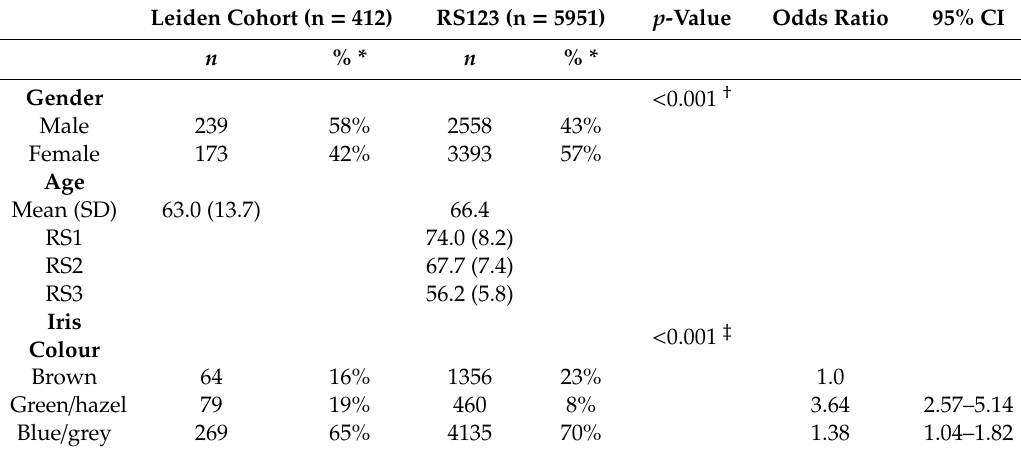
Table 1. Baseline characteristics of the study population of the Rotterdam Study (RS123) population (n = 5951) and the Leiden Uveal Melanoma cohort (n = 412). Leiden Cohort (n =